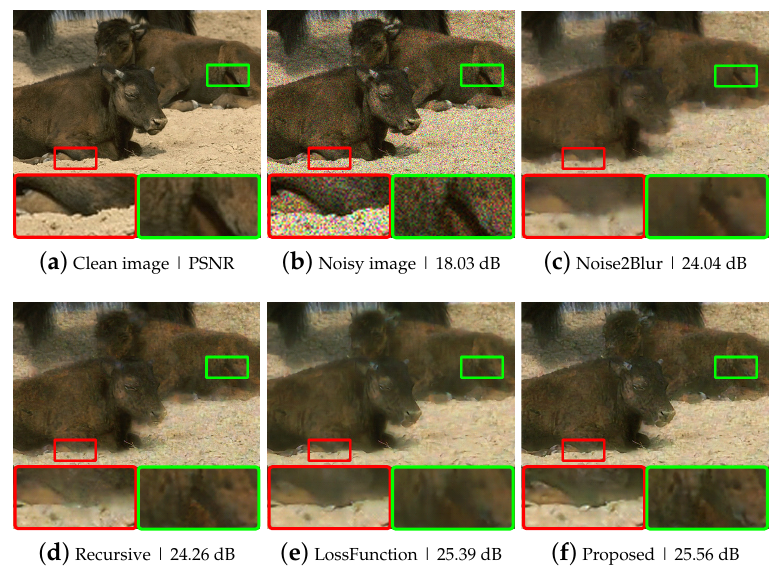
Figure 6. Example images of speckle denoising at v = 0.1: ( a ) a clean image; ( b ) a speckle noisy image; ( c – f ) example images of speckle denoising using various noise removal methods.